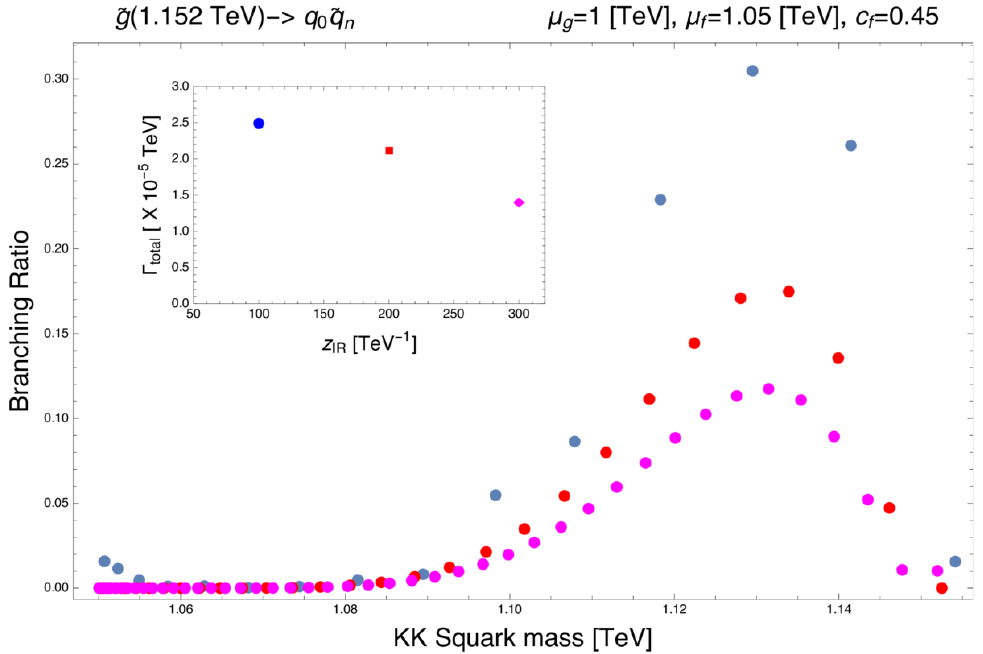
Figure 7. Examples of decay probabilities of one KK gluino with mass > (cid:22) f , decaying to the zero mode quark and a lighter KK squark. The branching ratios for di(cid:11)erent choices of z IR : 0.1 GeV (cid:0) 1 (blue), 0.2 GeV (cid:0) 1 (red), and 0.3 GeV (cid:0) 1 (pink) are shown. The subplot shows the decrease in the total decay width as z IR is